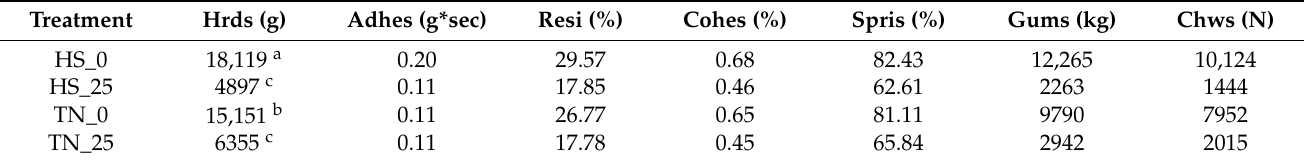
Table 5. Textural profile analysis of pork